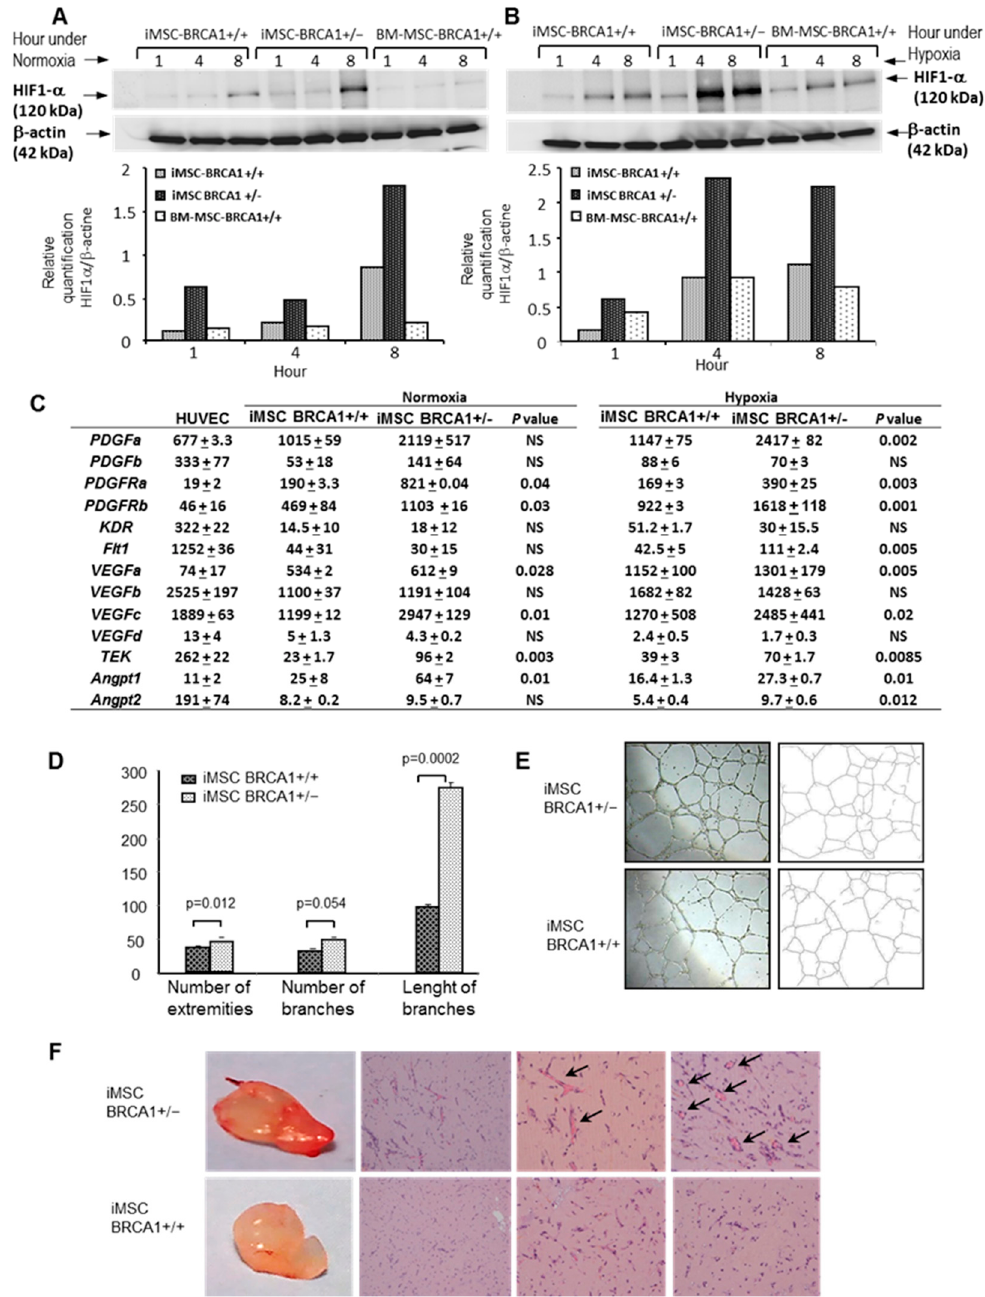
Figure 4. Pro-angiogenic properties of BRCA1 +/ − iMSCs ( A ) Western blot of relative HIF-1 α levels in BRCA1 +/ − iMSCs, BRCA1 +/+ iMSCs, and bone marrow-derived MSCs at 1, 4, and 8 h of culture under normoxia. ( B ) Quantification of HIF-1 α levels relative to β -actin in BRCA1 +/ − iMSCs, BRCA1 +/+ iMSCs, and bone marrow-derived MSCs at 1, 4, and 8 h of culture under hypoxia. ( C ) Expression of a variety of genes encoding hypoxia-inducible proteins in human umbilical vein endothelial cells (HUVECs) and in BRCA1 +/ − and BRCA1 +/+ iMSCs cultured for 4 days under normoxia and hypoxia, as determined by RT-PCR. ( D ) Matrigel angiogenesis assay using HUVECs and conditioned medium from BRCA1 +/ − or BRCA1 +/+ iMSCs, showing differences in the number of extremities and the length and number of branches. ( E ) Representative images of tube-like structures on an extracellular matrix. ( F ) Plug angiogenesis assay performed with BRCA1 +/ − and BRCA1 +/+ iMSCs. Macroscopic image of the plug after 10 days is shown as well as histological analysis after hematoxylin and eosin staining. Plugs created with BRCA1 +/ − iMSCs had complete tube-like vessel structures, with lumen containing a large number of red blood cells (arrows).